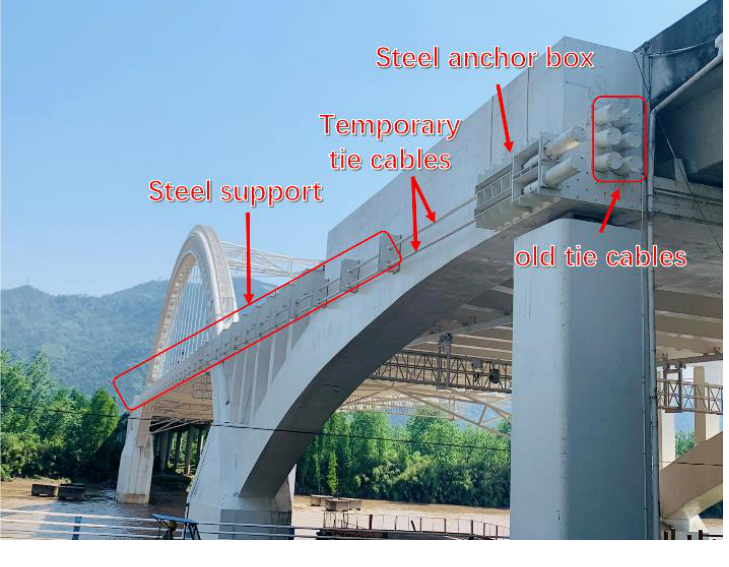
Figure 11. Temporary substitution system of the third Lingjiang bridge.